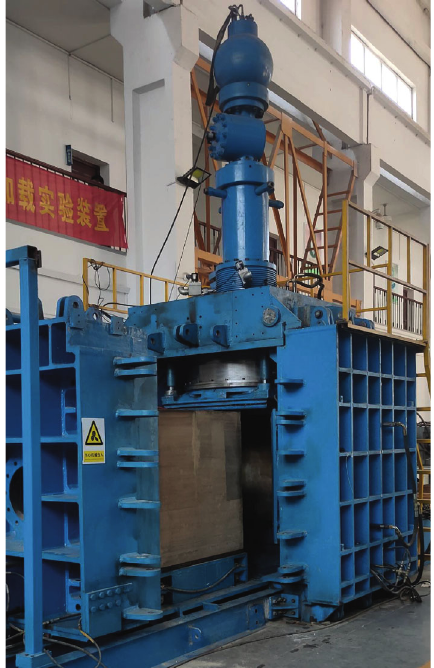
Figure 1: Deep-cavern ground-shock disturbance loading